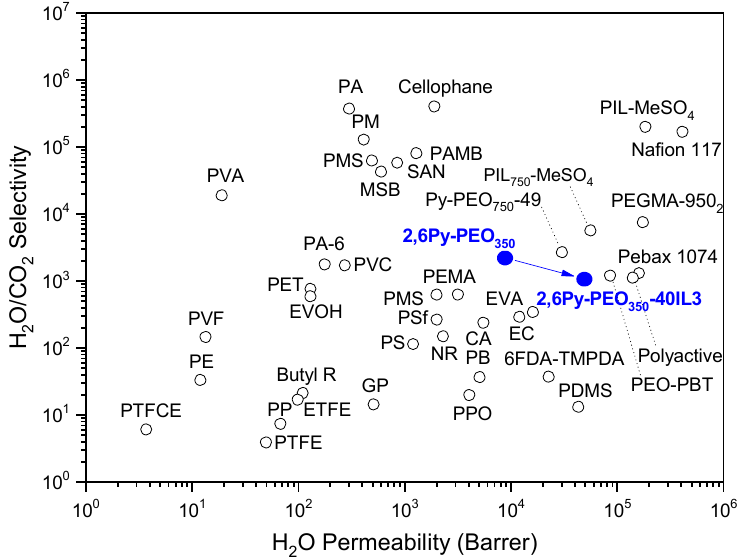
Figure 7. Comparison of H 2 O permeability with H 2 O/CO 2 selectivity of 2,6Py-PEO 350 and 2,6Py- PEO 350 -40IL3 membranes (blue circles) with other polymers reported in the literature (25–35 °C ) [33]. Table 2. Water vapor permeation properties of the precursor polymer and composite membrane containing 40 wt% [HMIM][TFSI] IL under dry and wet conditions (1 Barrer = 10 − 10 cm 3 (STP) cm cm − 2 s − 1 cm Hg − 1